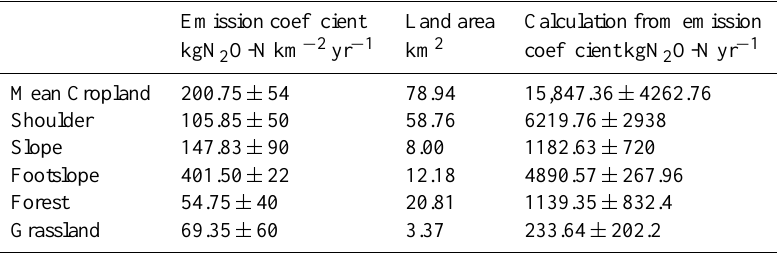
Fig. 4. Results of batch slurries: (a) potential rates of nitrate reduction by denitrification and production by nitrification; (b) potential N 2 O production and (c) ratio of N 2 O production to nitrate reduced (denitrification) or produced (nitrification). Table 2. Nitrous oxide emission for the types of land use associated with their respective surface area in the basin and calculations from coefficients including topographic